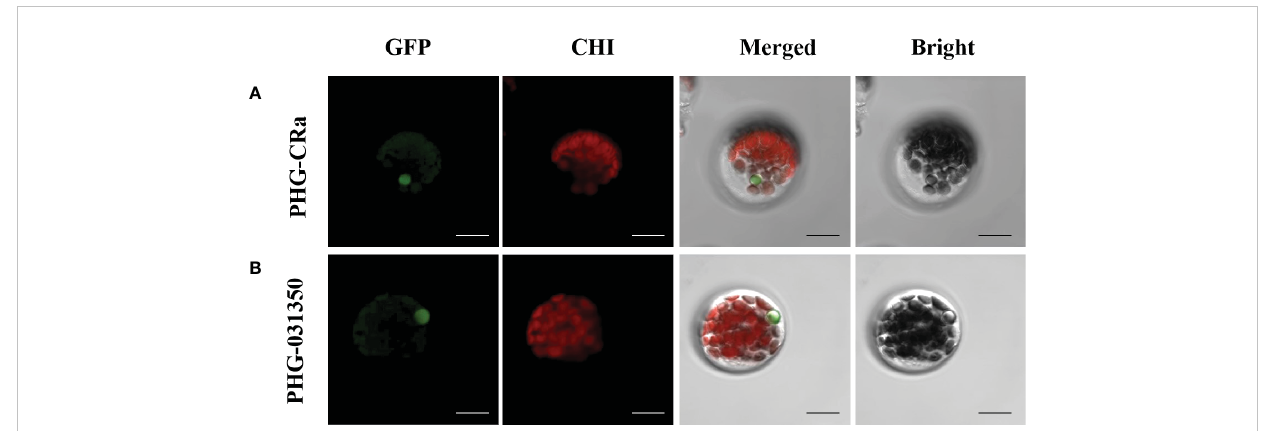
FIGURE 7 Subcellular localization of CRa and Bol031350 in broccoli. (A, B) presented PHG- CRa , and PHG- 031350 were all located in the cytoplasm and nucleus and transiently co-expressed in broccoli 19B42 protoplasts; Individual and merged images of GFP and chlorophyll auto fl uorescence (Chl) as well as bright fi eld images of protoplasts were shown. Scale bars = 5 m